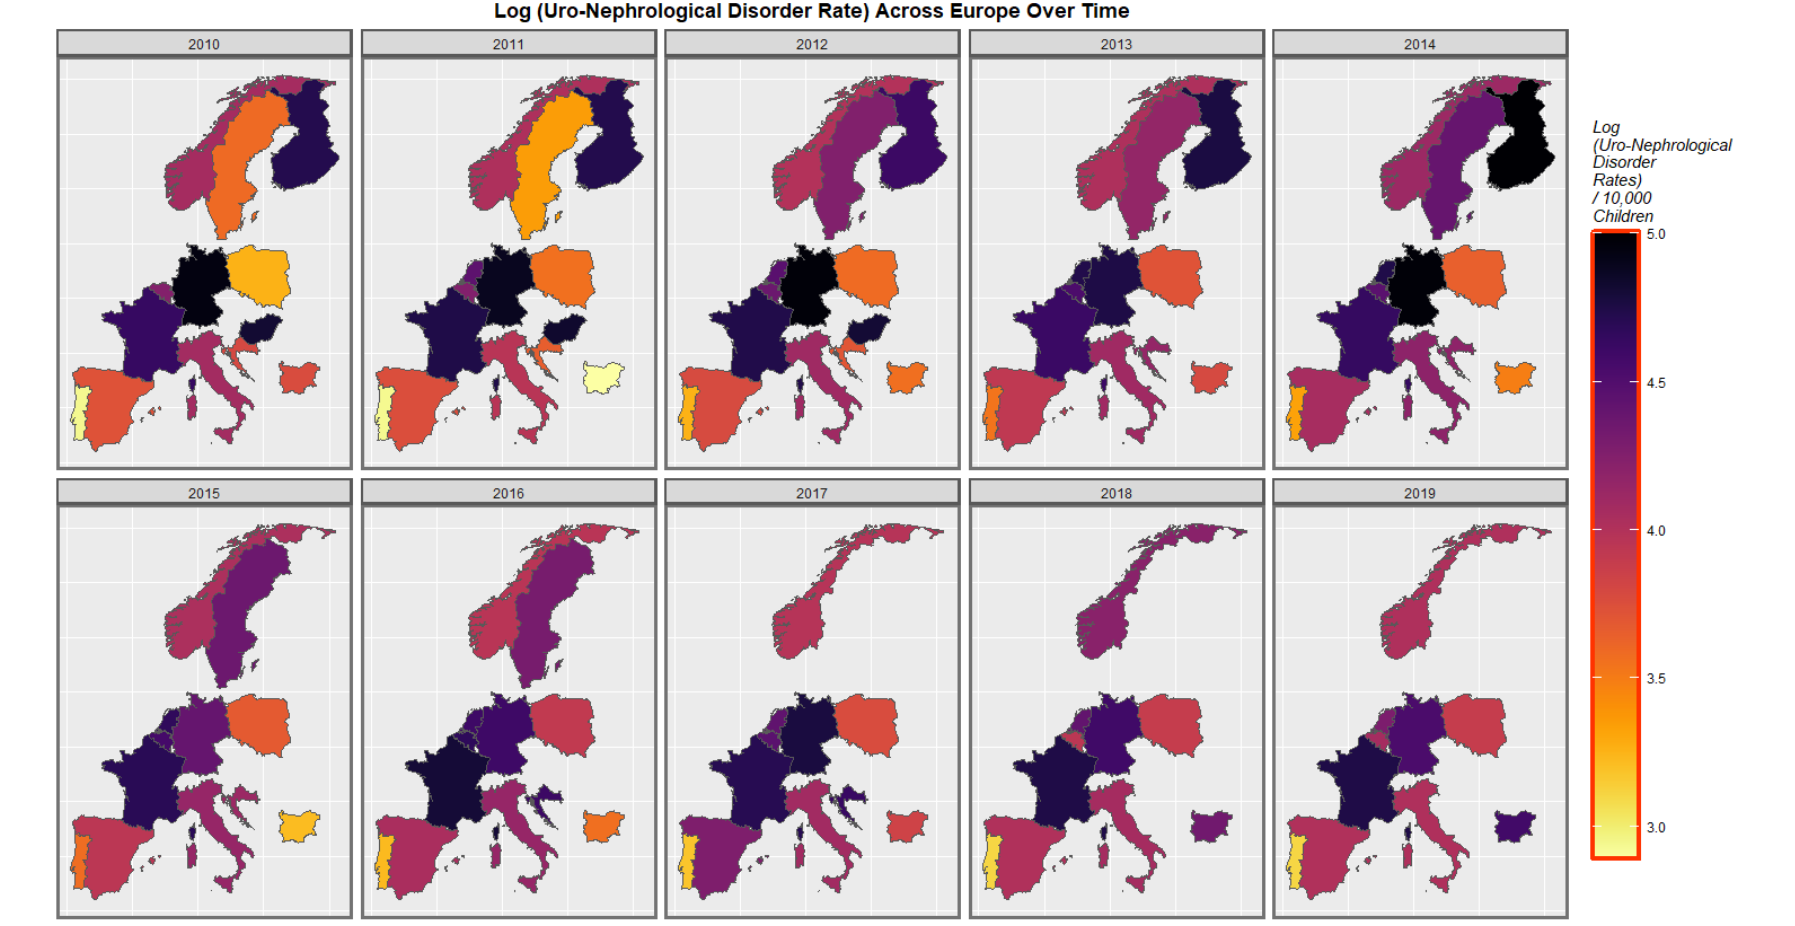
Figure 3. Time sequential map-graph of log (uronephrological anomaly rate) across surveyed European nations over time.